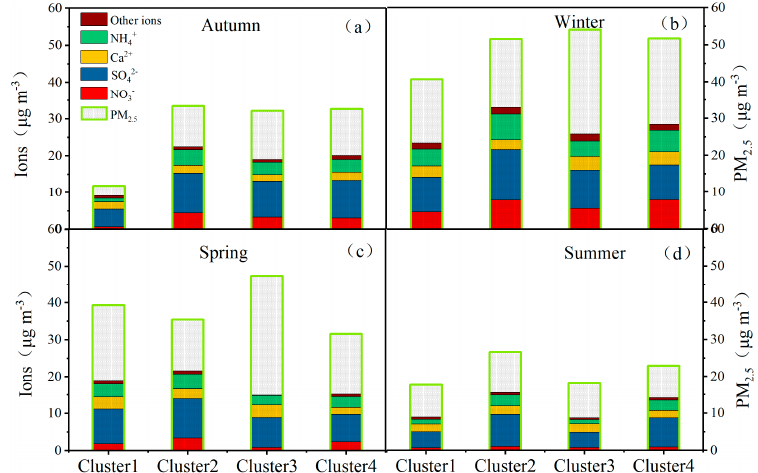
Figure 8. Corresponding mean concentration of measured species during sampling period ( a ) autumn; ( b ) winter; ( c ) spring; ( d ) summer).